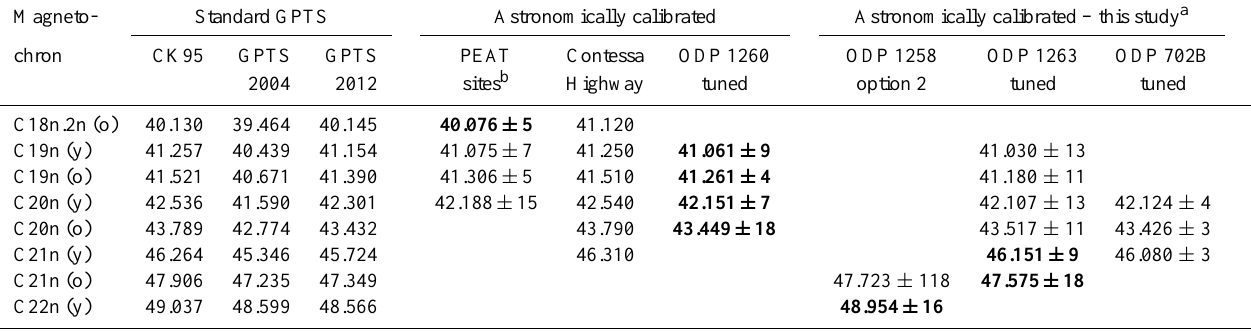
Table 1. Comparison of absolute magnetochron boundary ages in millions of years. Magneto- Standard GPTS Astronomically calibrated Astronomically calibrated – this study a